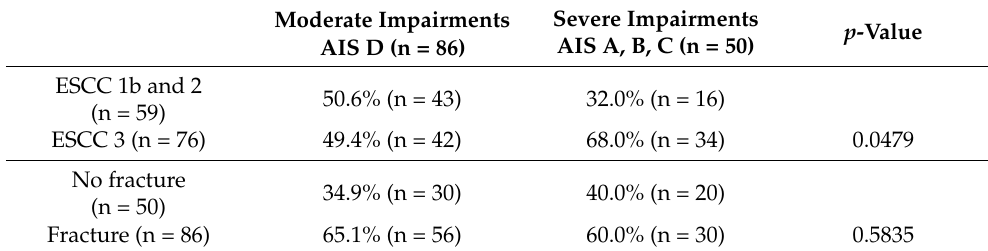
Table 4. Descriptive analysis.